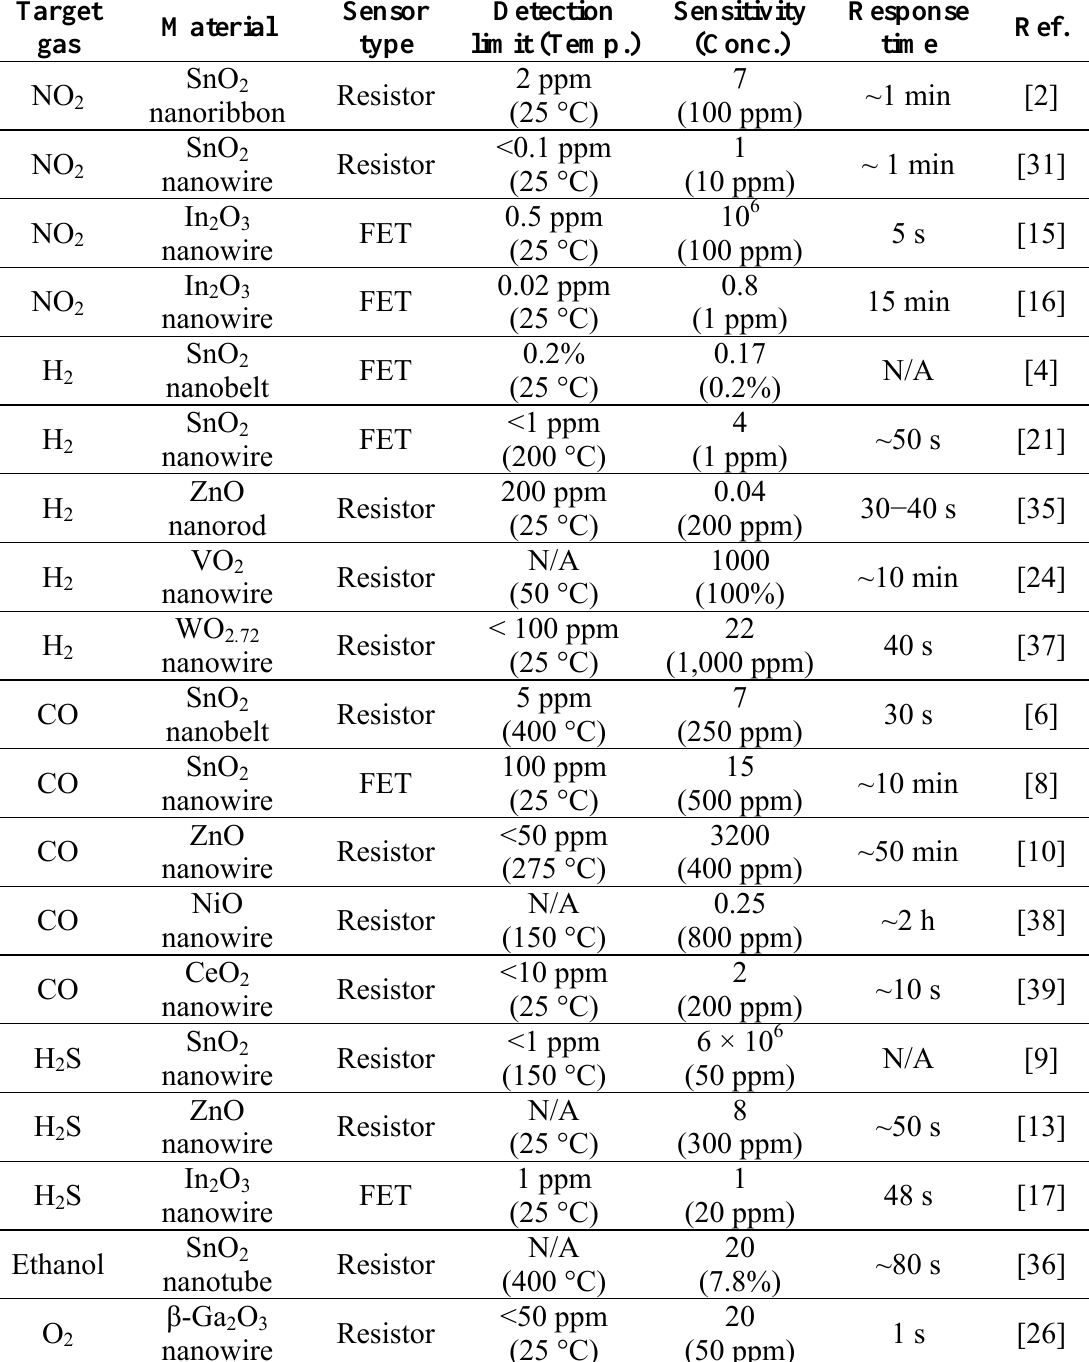
Table 1. Properties of gas sensors based on single 1D oxide